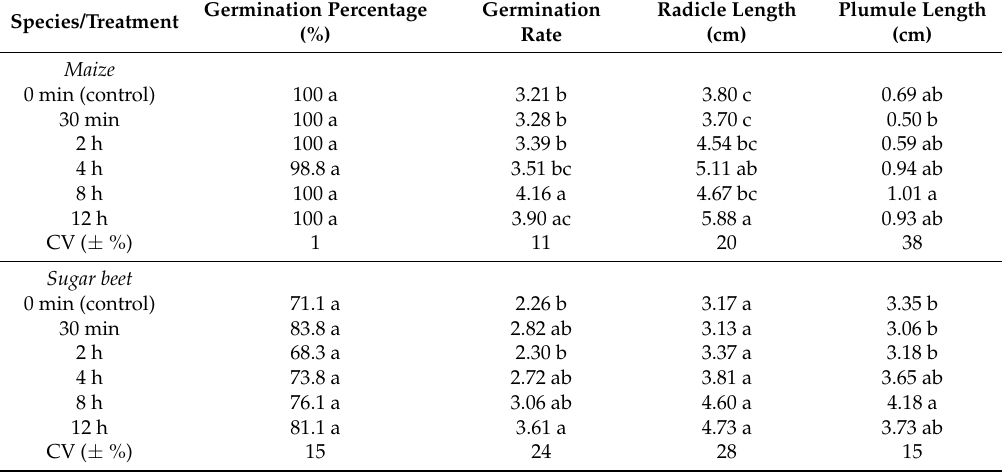
Table 2. Comparison of the arithmetic means of the seeds germination percentage, germination rate, radicle length, and plumule length affected by the UV-C radiation treatments (Tukey’s HSD, p < 0.05). Different letters within a column show a statistically significant